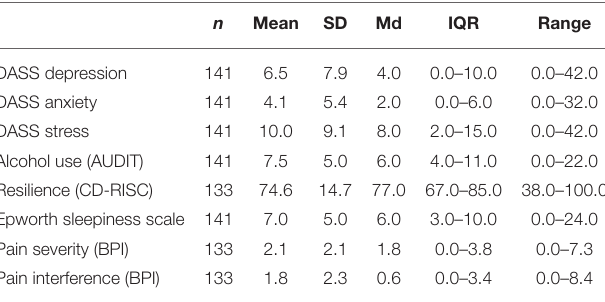
TABLE 3 | Self-report measures.